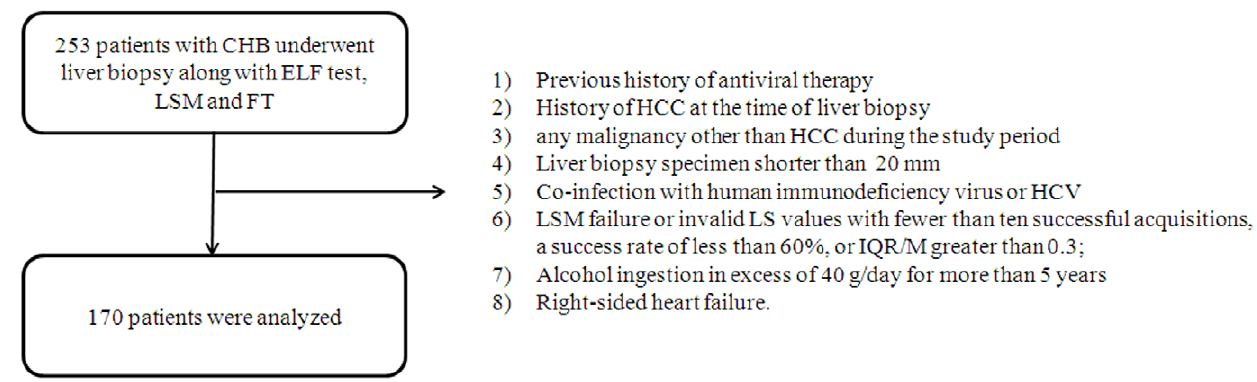
Figure 1. Flow chart describing the selection of the study population. Based on the exclusion criteria, 170 subjects were finally recruited for analyses.